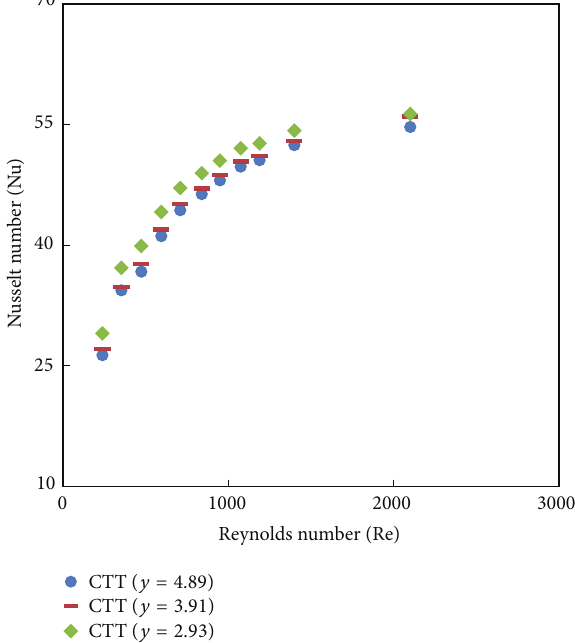
Figure 6: Simulated Nusselt friction factor of twisted tape with different twist ratios ( 𝑦 ).